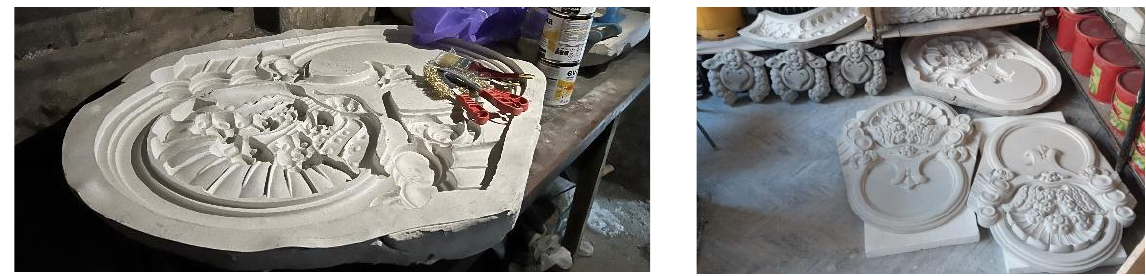
Figure 12. Molds for casting repetitive ornaments for the Lajos Besch and Károly Piffl Palace.